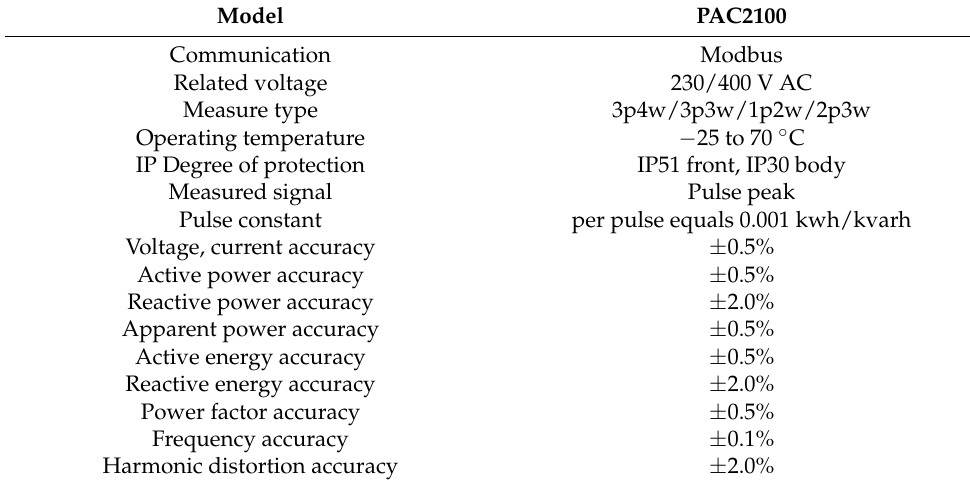
Table 8. Characteristics of the selected smart power meter.